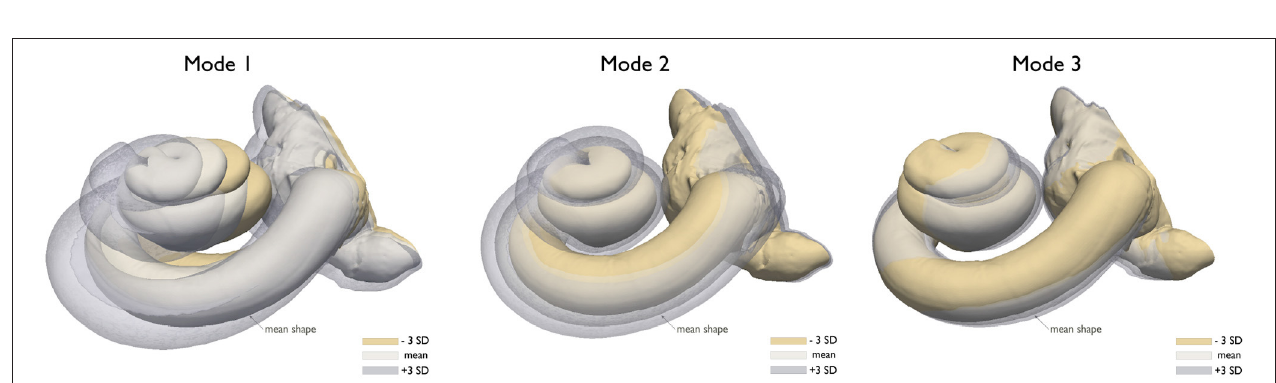
FIGURE 1 | CI evaluation framework. Input variables, for which uncertainty and variability are assessed, are shown at the top level. Their respective arrows indicate the step in which the uncertainty is introduced. Blue arrows show the workflow path of the framework for the two main blocks: model generation and functional evaluation. The evaluated output variables are shown at the bottom level.